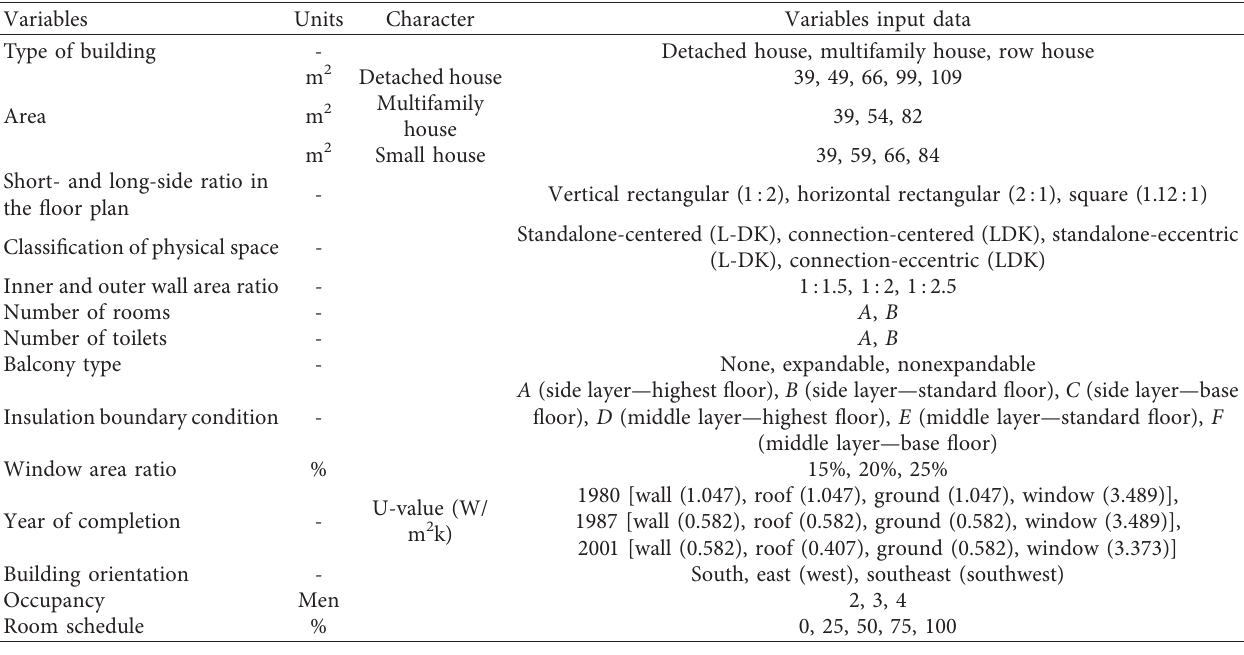
Table 9: Definition by variable.